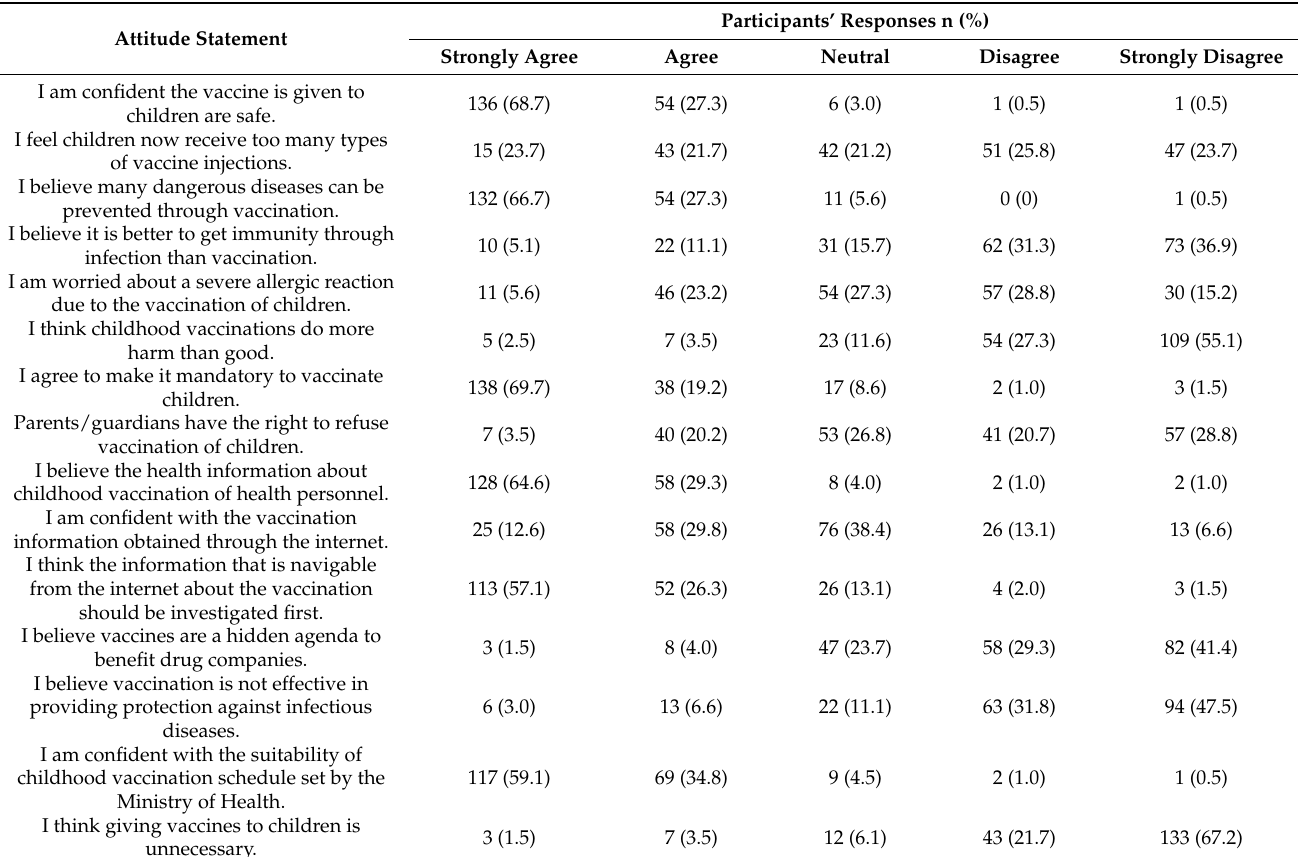
Table 2. Participants’ attitude on childhood